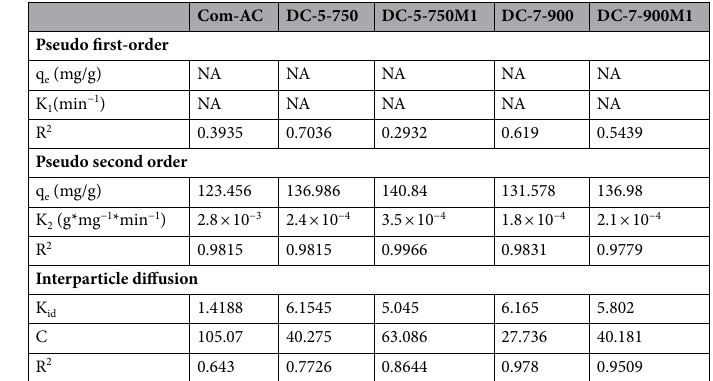
Table 8. Parameters value of MR PFO and PSO kinetic and intraparticle